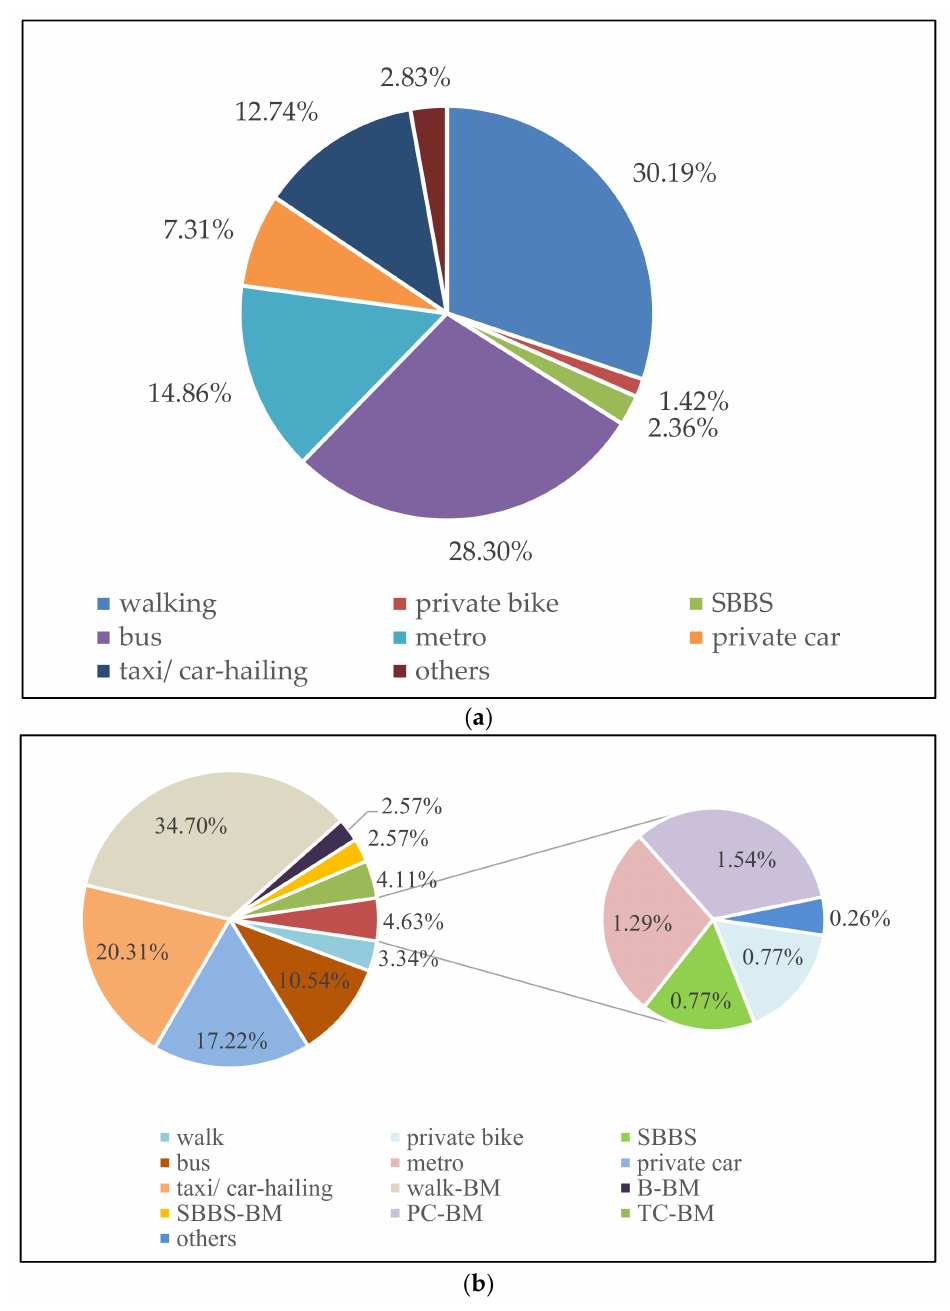
Figure 3. The proportion of different modes if FFBS is not available. ( a ) Directly used for a short- distance trip. ( b ) Connecting with bus or metro. PB-BM refers to the private bike connected to the bus or metro, SBBS-BM refers to the station-based bike sharing connected to the bus or metro, PC-BM refers to the private car connected to the bus or metro, TC-BM refers to the taxi/car-hailing connected to the bus or